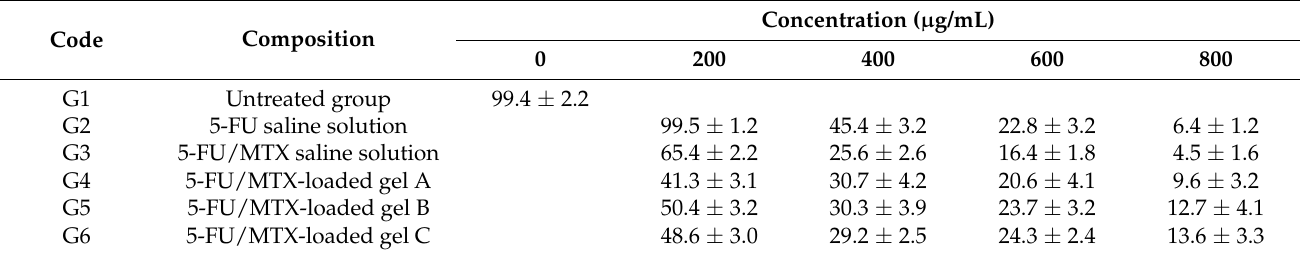
Figure 4. Cytotoxicity assay (% cell viability), as a function of drug concentration, loaded into the modified gel systems; G4 (8armPEG20k-CD/8armPEG20k-chol), G5 (p β -CD/8armPEG20k-Ad), and G6 (p β -CD/8armPEG20k-chol) compared with G2 (5-FU free saline solution) and G3 (5-FU/MTX free saline solution) against MCF-7 breast cancer cell line. The results are presented as the average of three independent measurements ± SD. Table 4. The percentage of breast cancer cell viability measurements as a function of concentration for all modified hydrogel systems compared to either free drug solutions or untreated